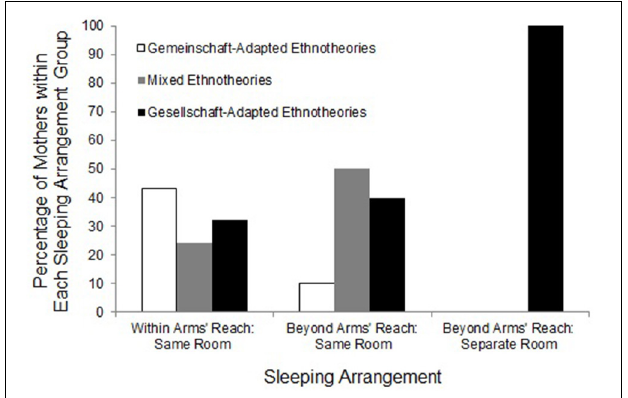
FIGURE 1 | Relationship between sleeping arrangement practices and maternal ethnotheories.